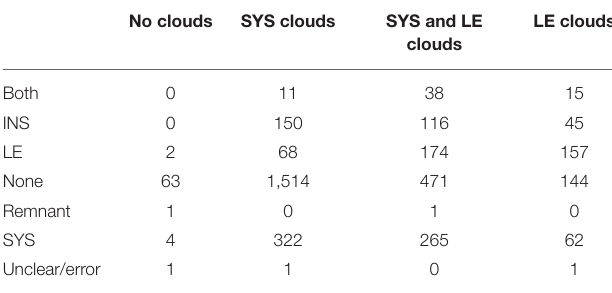
TABLE 2 | Comparison of classification and satellite-inferred cloud data. No clouds SYS